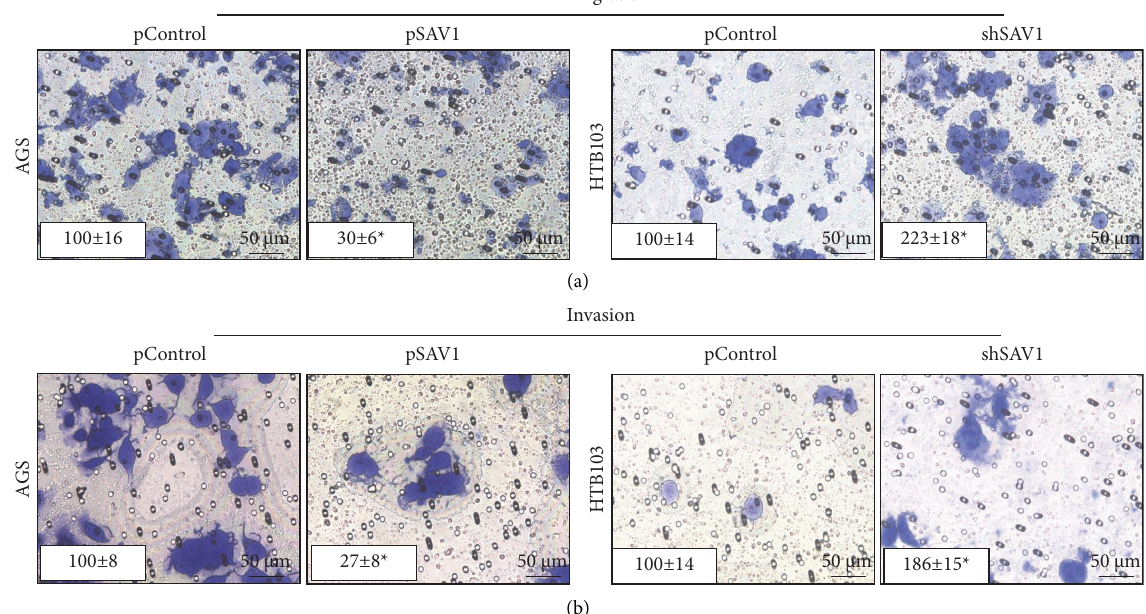
Figure 3: SAV1 inhibits gastric cancer cell migration and invasion in vitro. (a, b) AGS cells were transfected with pSAV1 or control vectors, and HTB103 cells were transfected with shSAV1 or control vectors. Te migration and invasion of AGS and HTB103 cells were determined. Te representative migrated or invaded tumor cells were photographed. Data represent the mean ± SD of triplicates. SAV1, Salvador homologue 1; shRNA, short hairpin